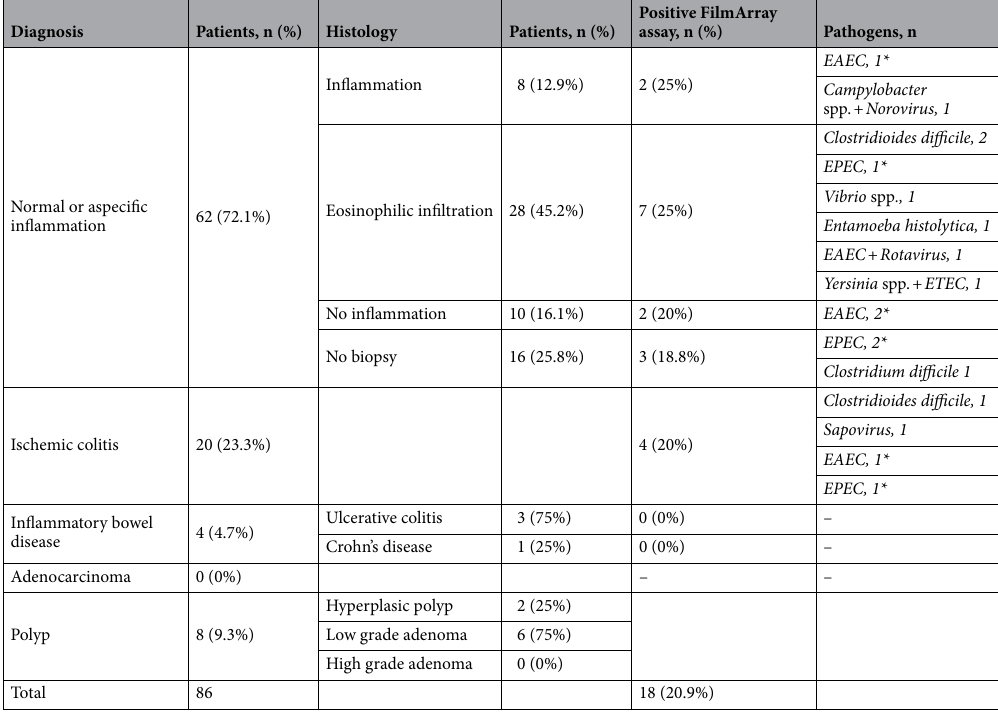
Table 3. Colonoscopy findings in patients with negative BD-Max. Colonoscopy was performed in patients with negative BD-Max. Biopsies were taken and sent for histological analysis. *Considered as carriage.